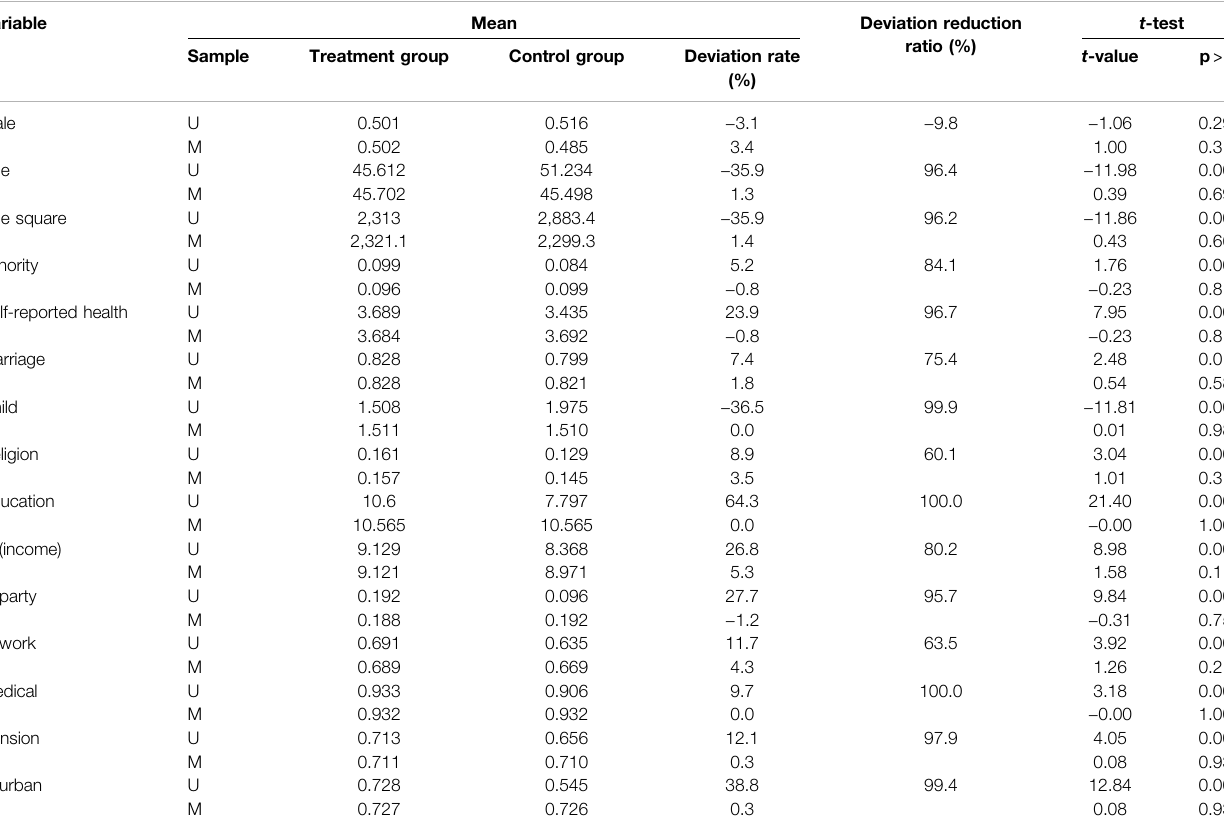
TABLE 4 | Balance test.